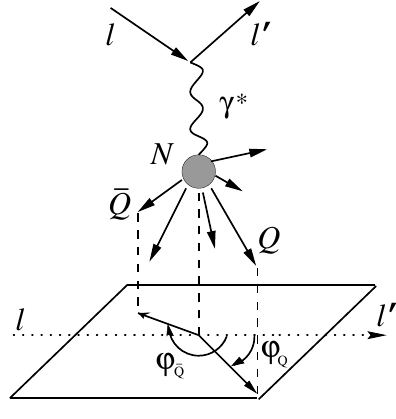
Figure 1. Definition of the azimuthal angles ϕ Q and ϕ ¯